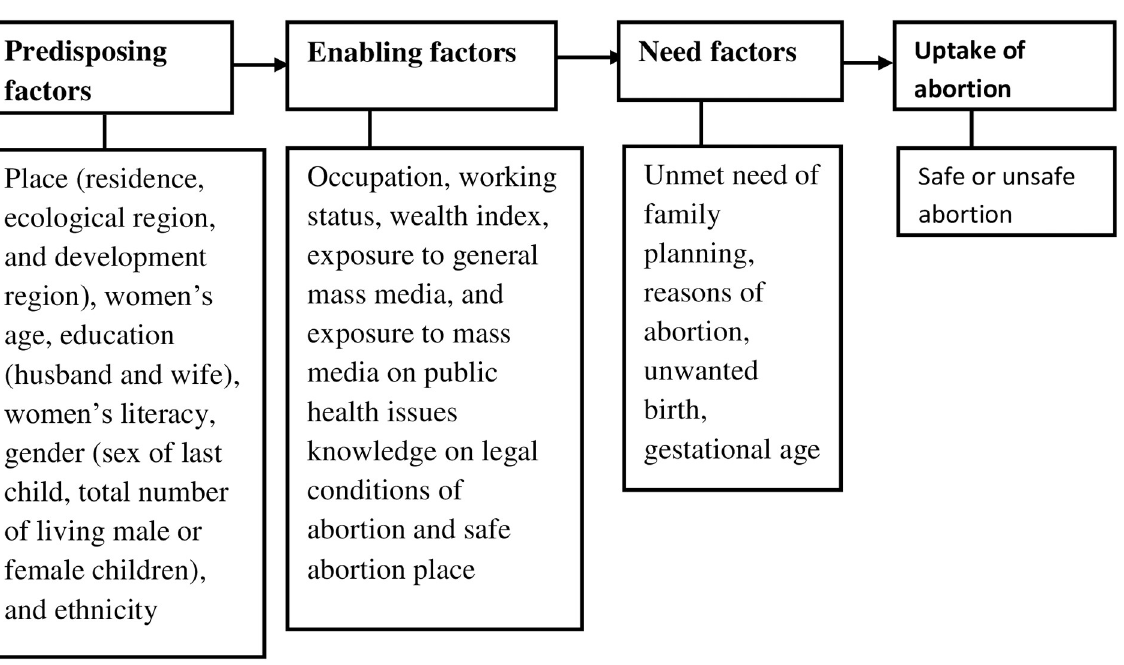
Fig 1. The conceptual framework of factors of unsafe abortion adapted from modified Anderson’s behavioural model [37].